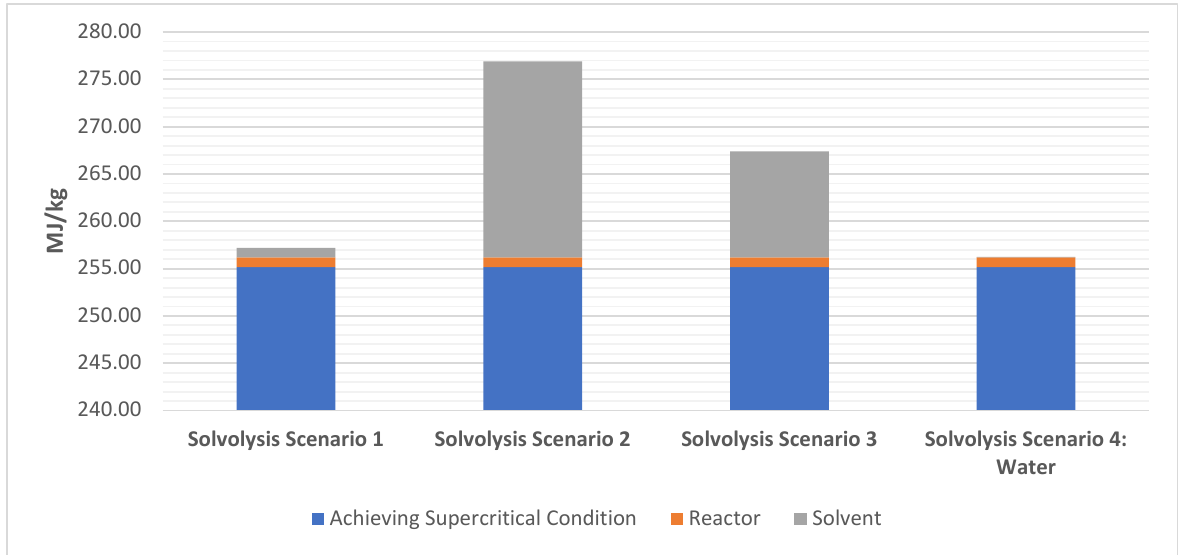
Figure 4. ( a ) Scenario 3a. EE comparison of Life 1 versus Life 2 for electric furnace scenario for py- rolysis; ( b ) Scenario 3B: EE comparison of Life 1 versus Life 2 for natural gas furnace scenario for pyrolysis.